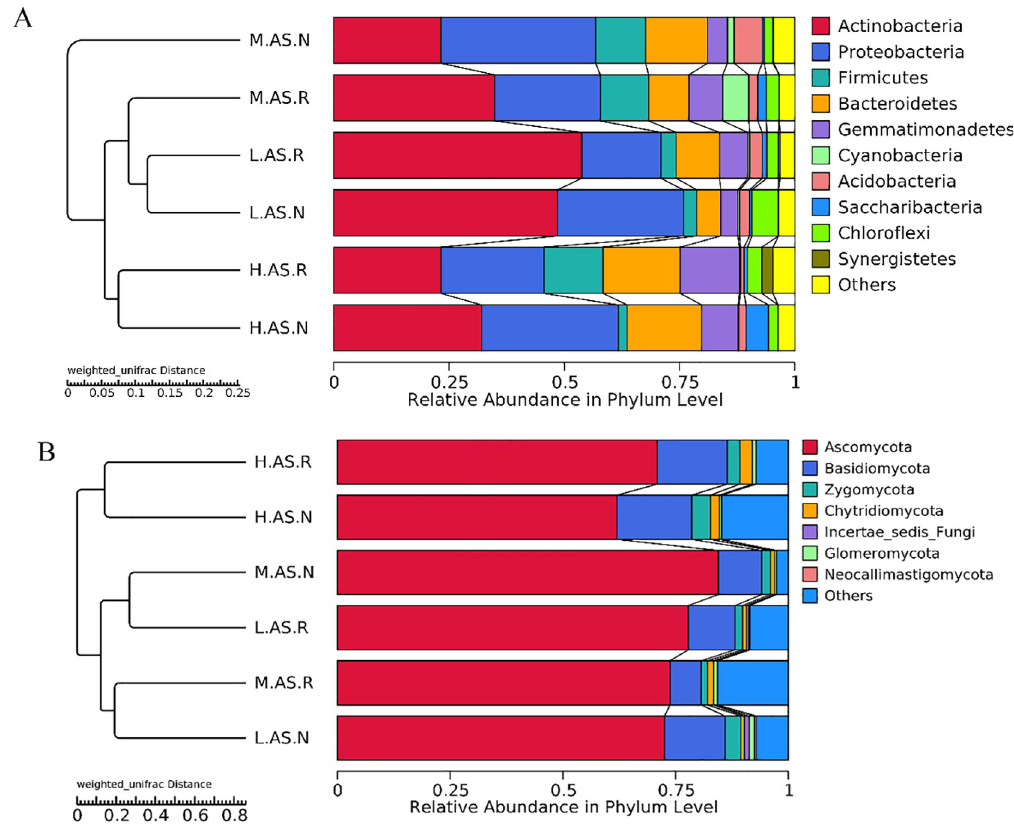
Fig 3. Diagrams depicting community composition and relative abundance at phylum levels: (A), bacteria; (B), fungi.